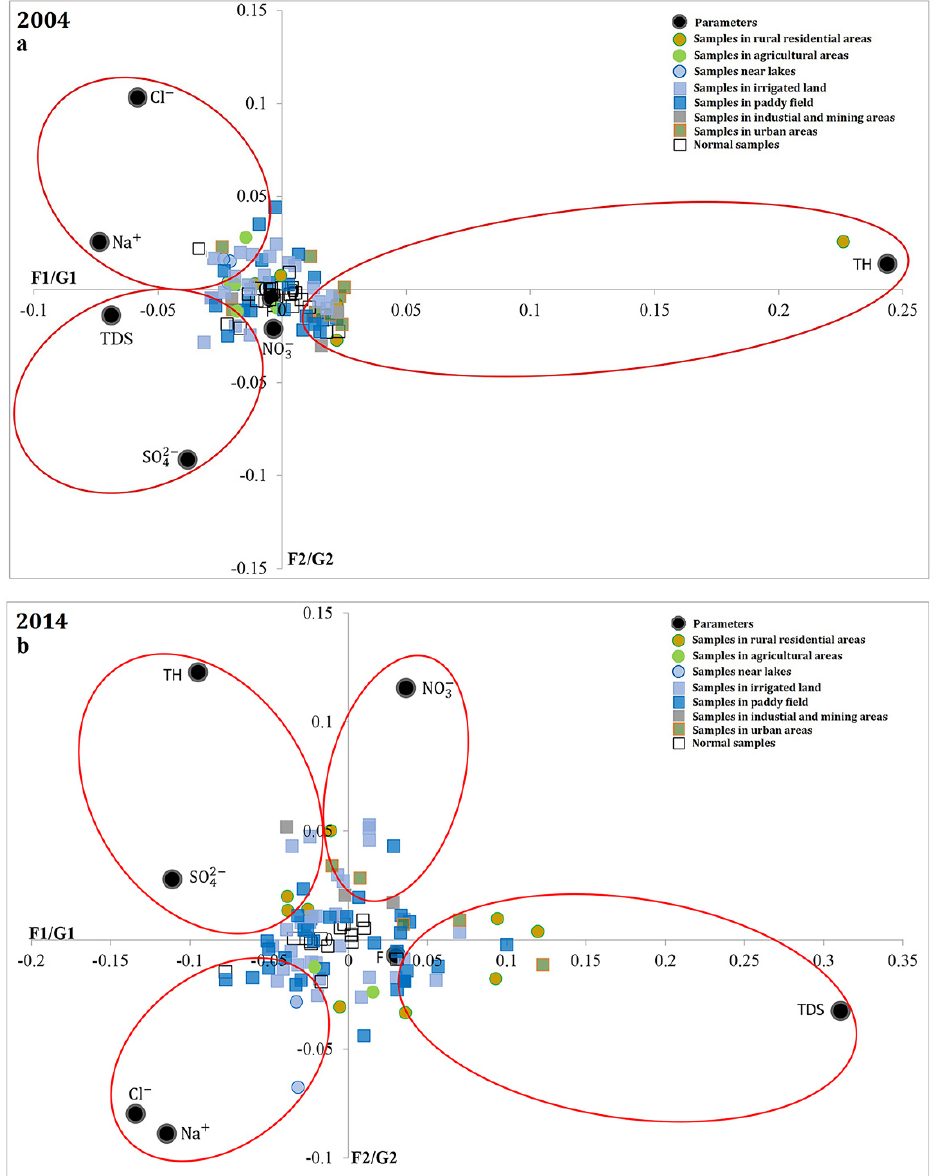
Figure 6. Distribution of variables and samples determined by correspondence analysis for F1 and F2 in ( a ) 2004 and ( b ) 2014. The red ellipses are drawn from the close degree of variables and